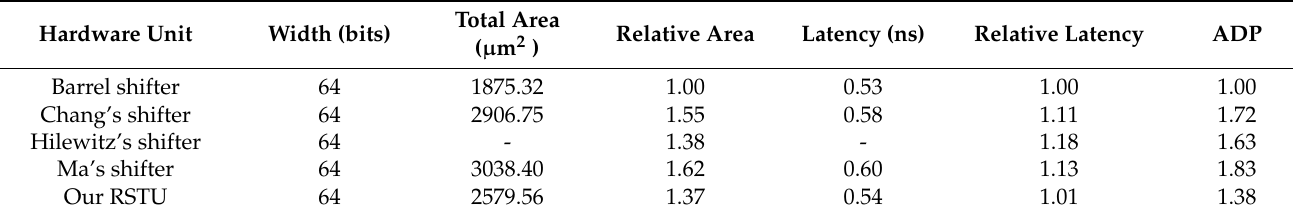
Table 2. Comprehensive performance